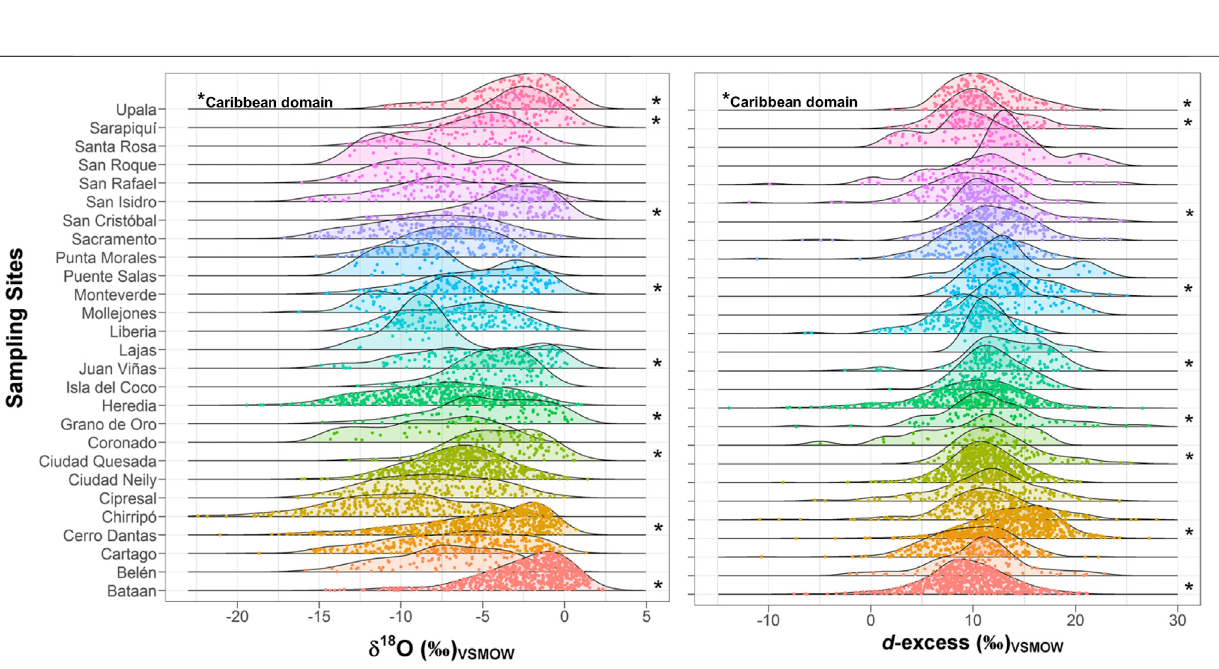
FIGURE 4 | Rainfall dual isotope and density diagrams. (A) Dual isotope diagram showing rainfall samples (N (cid:2) 5,905) collected across three domains: Caribbean (red), maritime (Cocos Island, green), and Paci fi c (blue) from 2013 to 2019. Local meteoric water lines (LMWLs) are included for reference. (B) Density plots of δ 18 O and δ 2 H across the Caribbean (red), maritime (Cocos Island, green), and Paci fi c (blue) domains. Color-dashed lines denote median values. Figure adapted using data from Sánchez-Murillo et al. (2013; 2016; 2017a,b; 2019a; Corrales-Salazar et al., 2016; Esquivel-Hernández et al., 2018, 2019; Munksgaard et al., 2019; Welsh and Sánchez-Murillo, 2020).